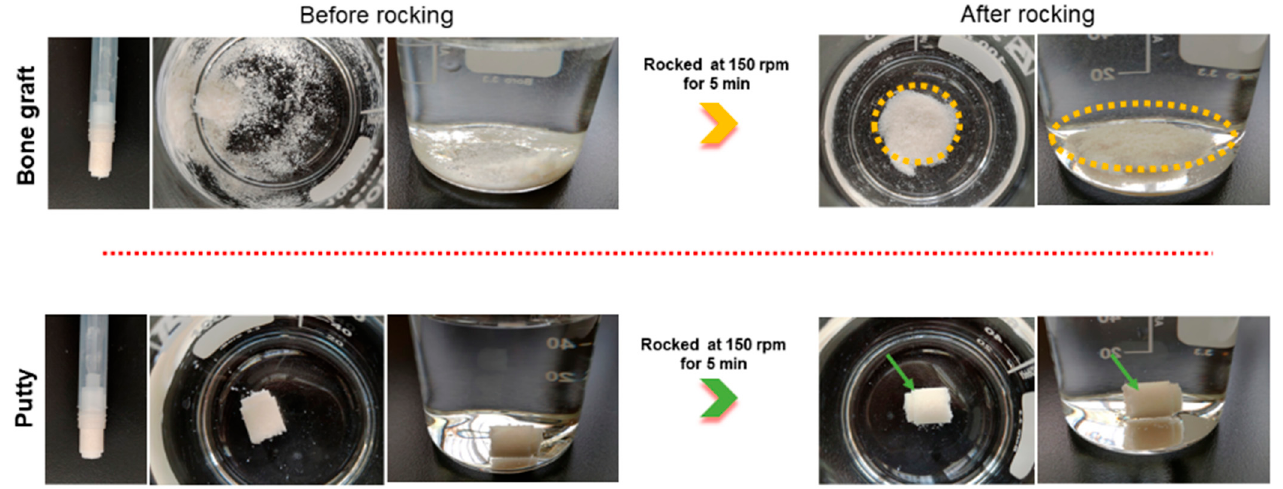
Figure 2. Schematic illustration of the hydrated bone graft and putty after rocking for five minutes in saline. The green arrow indicates cohesiveness.